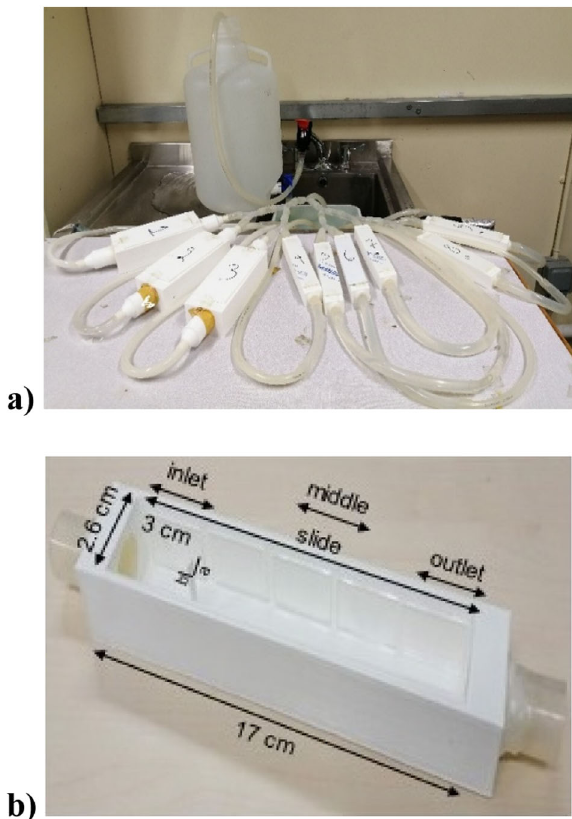
Fig. 1 An example of the experimental set-up. a The experimental set-up of the fi rst set of experiments comprising of the tap, the water tank, the tubing and valves, the channels (1-3 for LVF, 4-6 for SF and 7-9 for SVF), and the water basin in the sink. b The inside of a SVF channel (17 cm length and 2.6 cm width) with the location of the slide sections (inlet, middle and outlet) which are 5 in total of 3 cm length and separate from each other by 0.4 cm, and the position of the triangular object (a = 0.6 cm and b = 0.2 cm) at 3 cm from the entrance.